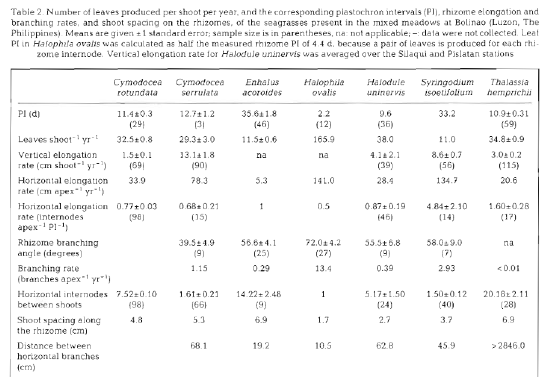
Figure 2. Number of leaves produced per shoot per year, rhizome elongation and branching rates and shoot spacing on the rhizomes of seagrasses present in the mixed meadow at Bolinao, Pangasinan (Vermaat et al., 1995). The flowering frequencies of E. acoroides , T. hemprichii and